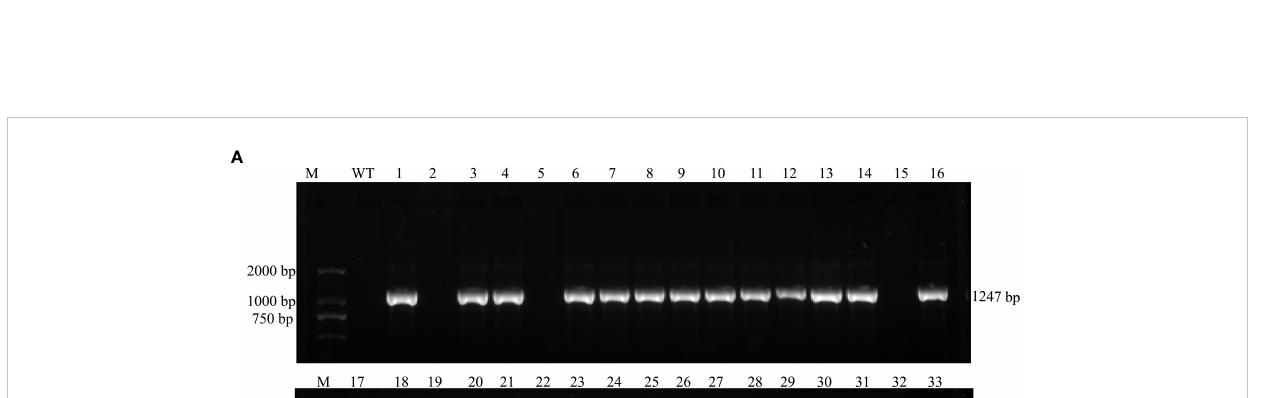
FIGURE 2 Subcellular localization of MirMAN. (A) Subcellular localization of 35S: MirMAN: GFP in tobacco cells. (B) Subcellular localization of 35S: MirMAN: GFP following 30% sucrose treatment. Bar = 50 m m. After plasmolysis, GFP signal observed in the cell wall is indicated by white arrows.